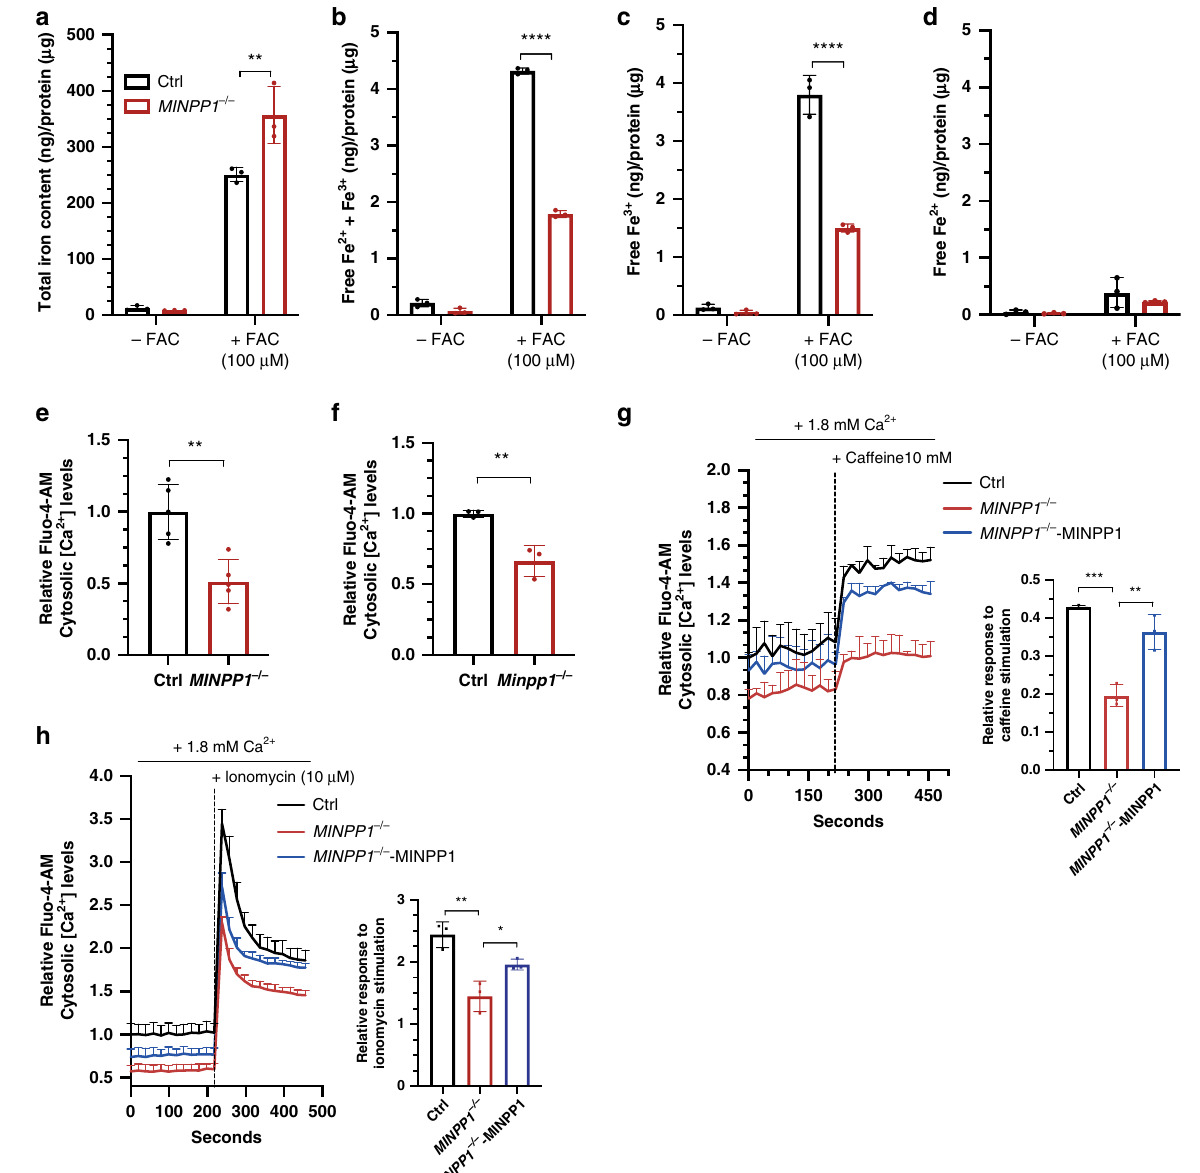
Fig. 5 Altered iron and calcium homeostasis in the absence of MINPP1 enzyme in HEK293 and Minpp1 − / − mouse neural progenitor cells. a – d Quanti fi cation of total iron content ( a ), free iron (Fe 2 + and Fe 3 + ) ( b ), Fe 3 + ( c ), and Fe 2 + ( d ) levels in extracts from control and MINPP1 − / − HEK293 cells grown under low ( − FAC) and high iron ( + FAC, 100 µ M) conditions. All values are normalized to the total protein concentration and represent the mean ± s.d ( n = 3, two-way ANOVA Sidak test, ** p ≤ 0.01 and **** p ≤ 0.0001. For ( a ), Ctrl vs. MINPP1 − / − : p = 0.0023; for ( b ), Ctrl vs. MINPP1 − / − : p ≤ 0.0001, and for ( c ), Ctrl vs. MINPP1 − / − : p ≤ 0.0001). e , f Relative Fluo-4-AM cytosolic Ca 2 + levels in control and MINPP1 − / − HEK293 cells ( e ), wild-type (WT) and Minpp1 − / − E14 mouse neural progenitors ( f ). g , h Relative Fluo-4-AM cytosolic Ca 2 + levels in control, MINPP1 − / − and MINPP1-overexpression stable line in MINPP1 − / − HEK293 cells ( MINPP1 − / − -MINPP1) loaded either with 10 mM caffeine ( g ) or 10 µ M ionomycin ( h ). The dotted line indicates the addition of either caffeine ( g ) or ionomycin ( h ). Relative response after caffeine or ionomycin stimulation (peak) is represented graphically (inset). For all of the calcium assay experiments, the data are normalized to cell number with MTT colorimetric assay and presented as mean values relative to control baseline fl uorescence intensity control ± s.d. (( e ) n = 5; ( f ) N = 3 mice, ( g , h ) n = 3, two-tailed student ’ s t -test ( e , f ) and one-way ANOVA, Tukey ’ s post hoc test ( g , h ), * p ≤ 0.05, ** p ≤ 0.01, *** p ≤ 0.001). For ( e ), Ctrl vs. MINPP1 − / − : p = 0.0021; for ( f ), Ctrl vs. Minpp1 − / − : p = 0.007; for ( g ), Ctrl vs. MINPP1 − / − : p = 0.0002; MINPP1 − / − vs. MINPP1 − / − -MINPP1: p = 0.0015; for h Ctrl vs. MINPP1 − / − : p = 0.0018; MINPP1 − / − vs. MINPP1 − / − -MINPP1: p = 0.0402. For all panels, source data are provided as a source data fi